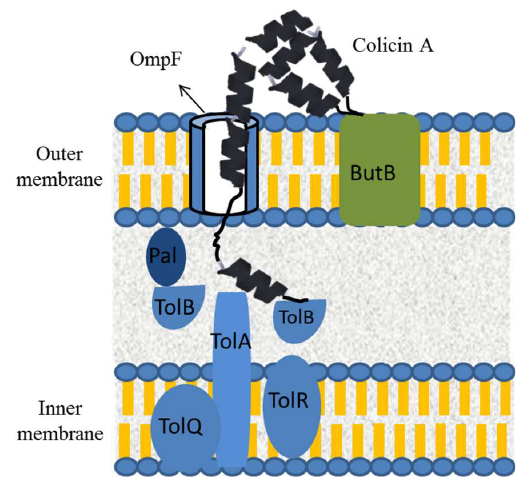
Figure 7. Colicin A entry inside sensitive bacterial strains. Colicin A first binds to the ButB outer membrane receptor and then uses the OmpF translocator to cross the outer membrane. Colicin A is then guided by the TolA-Pal system and its pore-forming domain is inserted into the inner membrane.